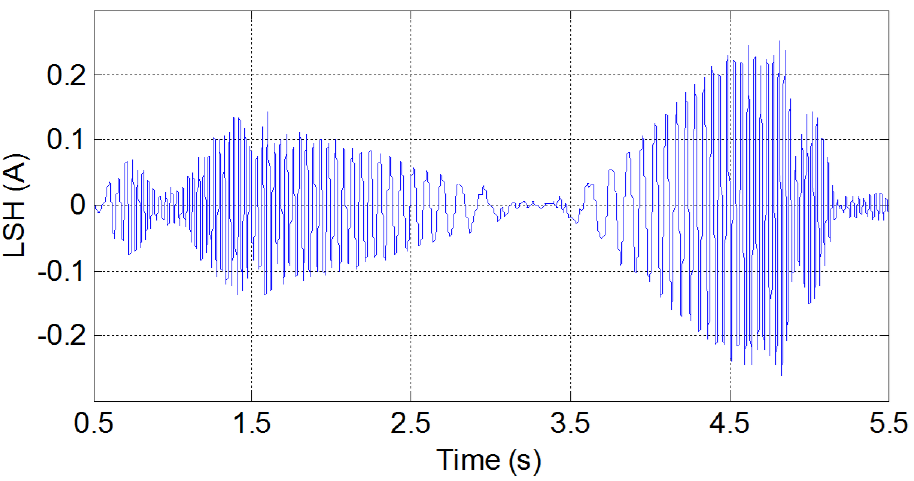
Figure 10. Experimental LSHst of the machine with one broken